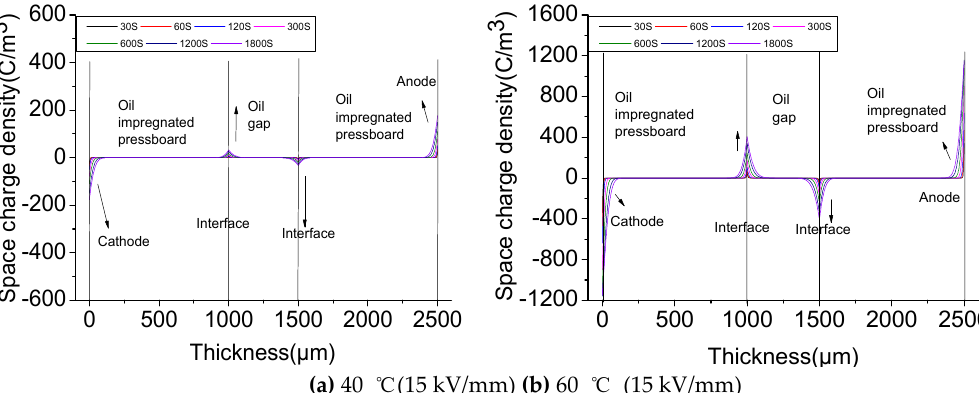
Figure 9. Space charge simulation of three-layer “OIP+ OG + OIP” system under different temperatures. The relationship between the charge density at the interface adjacent to the cathode for the oil-insulation structure with different layers at steady state and the temperature is shown in Figure 10. It can be found that the charge density absolute values at steady state increase exponentially with